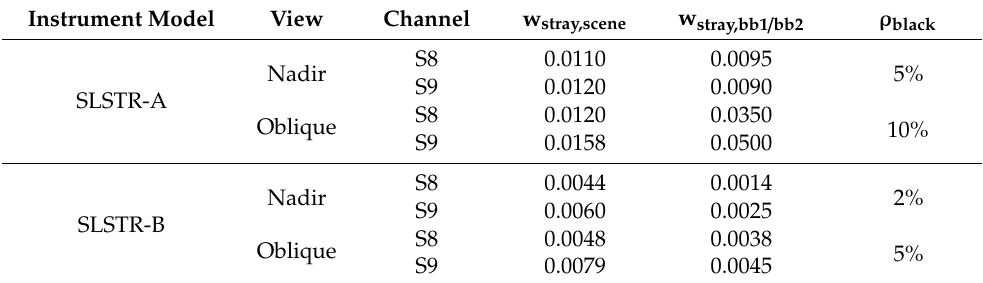
Table 8. Stray light coe ffi cients w stray for the stray light model derived from the measurements and the hemispherical reflectance of the black coatings, ρ black , used for the primary aperture stop. Instrument